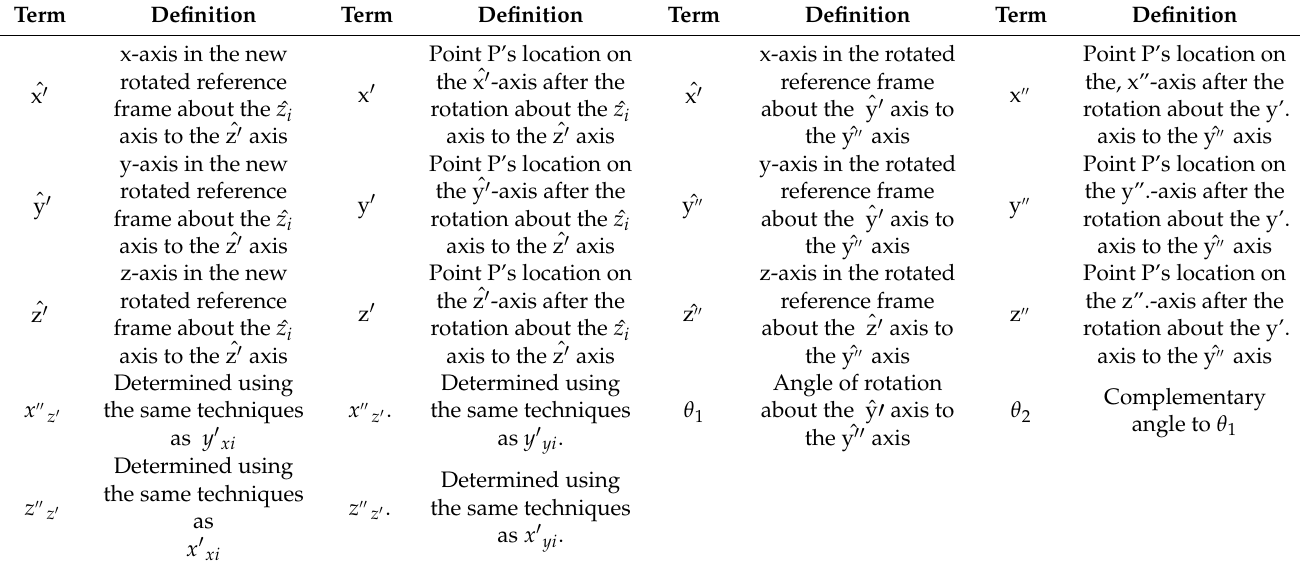
Table 4. Proximal variable and nomenclature definitions for Figure